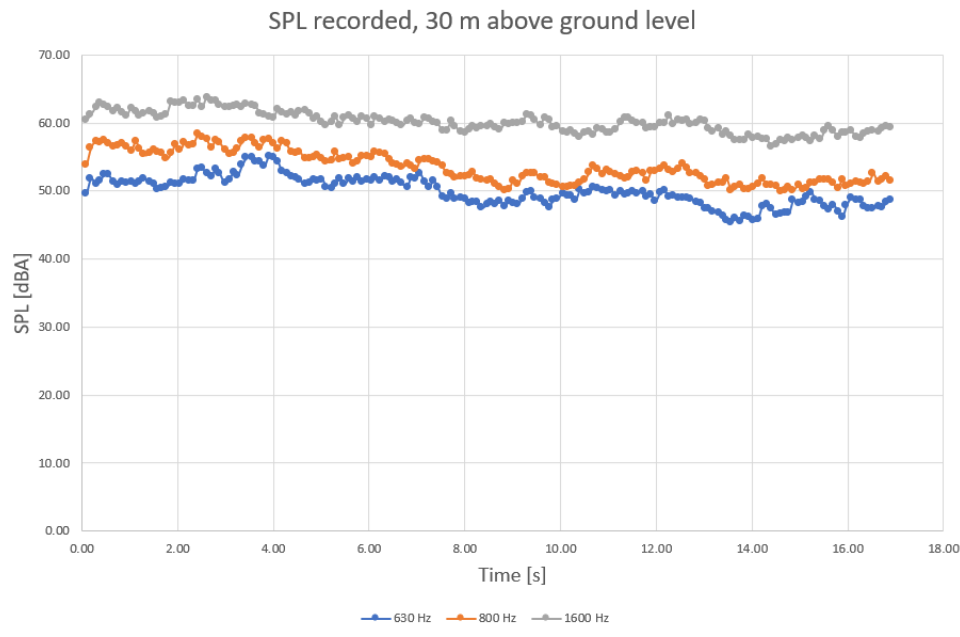
Figure 9. SPL recorded for medium frequency range, 30 m level (630 Hz, 800 Hz, and 1.6 kHz traffic noise, in blue—630 Hz, orange—800 Hz, grey—1.6 kHz).